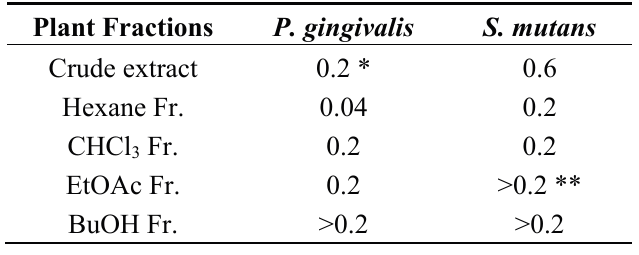
Table 2. MIC value of crude extract and fractions of Robinia pseudoacacia against the tested